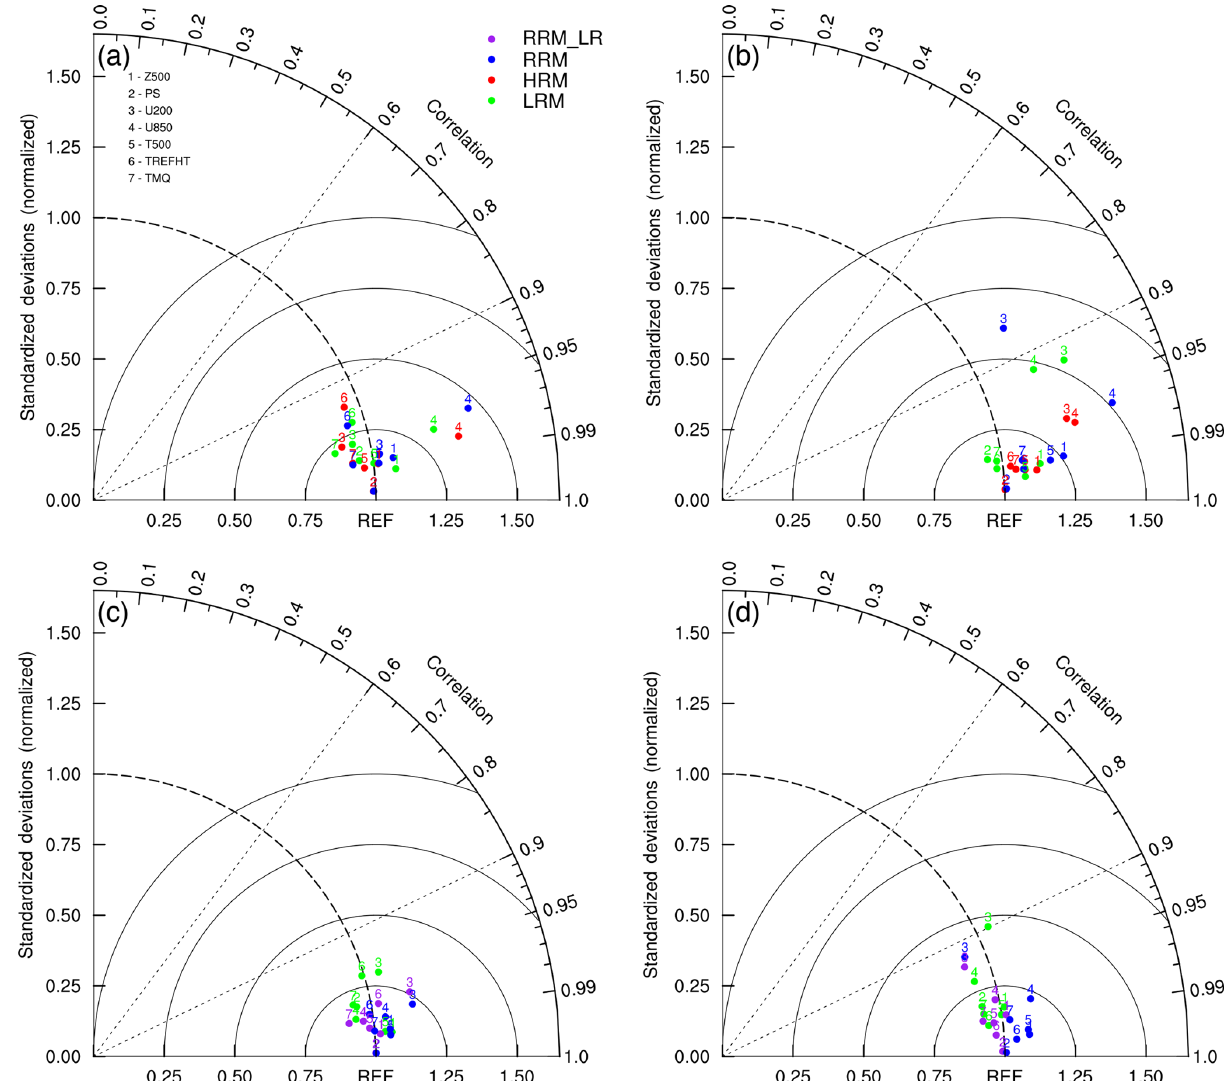
Figure 2. Taylor diagrams for three different model climatologies (color-coded: green – LRM; red – HRM; blue – RRM; and purple – RRM_LR) in JJA (a, c ) and DJF (b, d) . Results are from the CONUS domain (the blue box in Fig. 1b). For panels (a) and (b) , verification data are used as the reference point (1, 0), and statistics are calculated on the coarser verification grids. For panels (c) and (d) , the HRM is the reference, and statistics are calculated on the HRM grids. The numbers represent the following: 1 – 500hPa geopotential height ( Z